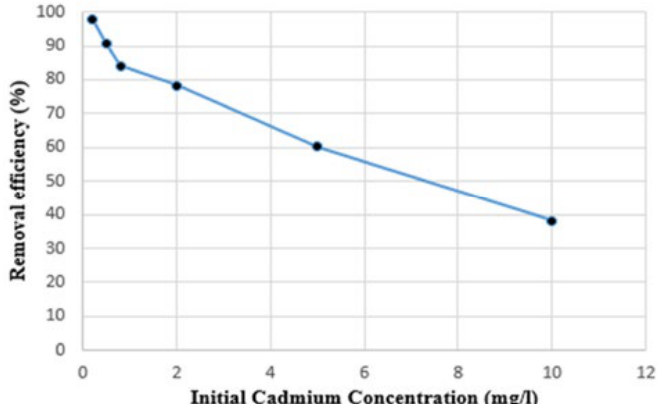
Fig. 9. Efficacy of initial cadmium concentration on the removal process by palladium oxide nanoparticles